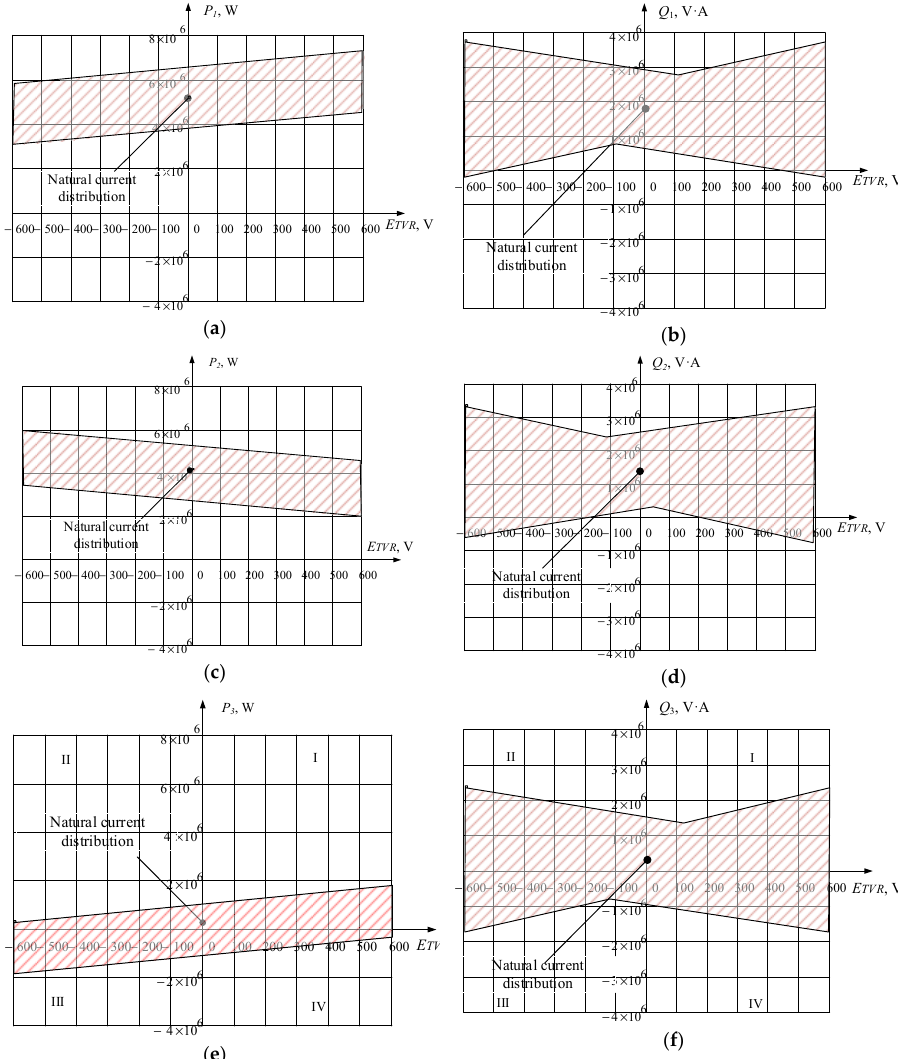
Figure 14. Ranges of real and reactive power changes of DN parts under combined control mode: ( a ) P 1 , ( b ) Q 1 , ( c ) P 2 , ( d ) Q 2 , ( e ) P 3 , and ( f ) Q 3 . It has been established that in all ranges of the combined control mode, the real power flows P 1 and P 2 do not change their sign. Consequently, the direction of real power in the DN containing distribution transformers (Figure 7) is unchanged and is directed from the high-voltage network to the load.